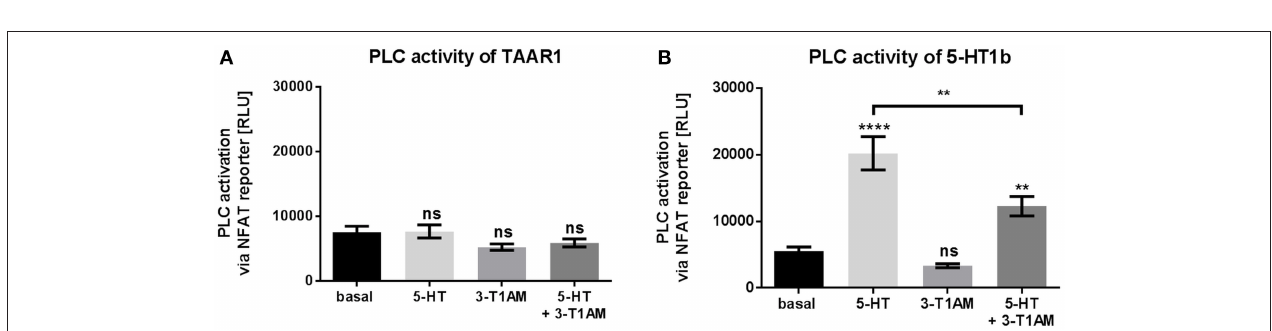
FIGURE 2 | The TAAR1 agonist 3-T1AM can activated G i / o signaling through 5-HT1b, but not G s signaling. To measure G s and G i / o , the cAMP content was determined via an AlphaScreen technology. HEK293 were used to overexpress 5-HT1b. An empty vector was used for mock transfection, which showed no endogenous effect of 5-HT or 3-T1AM (see Supplemental Figures 1A,B). (A) 5-HT1b was stimulated with either 5-HT, 3-T1AM or both in a concentration of 10 µ M. n = 5 measured in triplicates. (B) 5-HT1b was stimulated with forskolin and either 5-HT, 3-T1AM or both in a concentration of 10 µ M. n = 13 measured in triplicates. For statistics, a one-way ANOVA was performed and the mean of each column was compared with the mean of all other columns. Statistical significance was defined as *** p ≤ 0.001, **** p ≤ 0.0001.